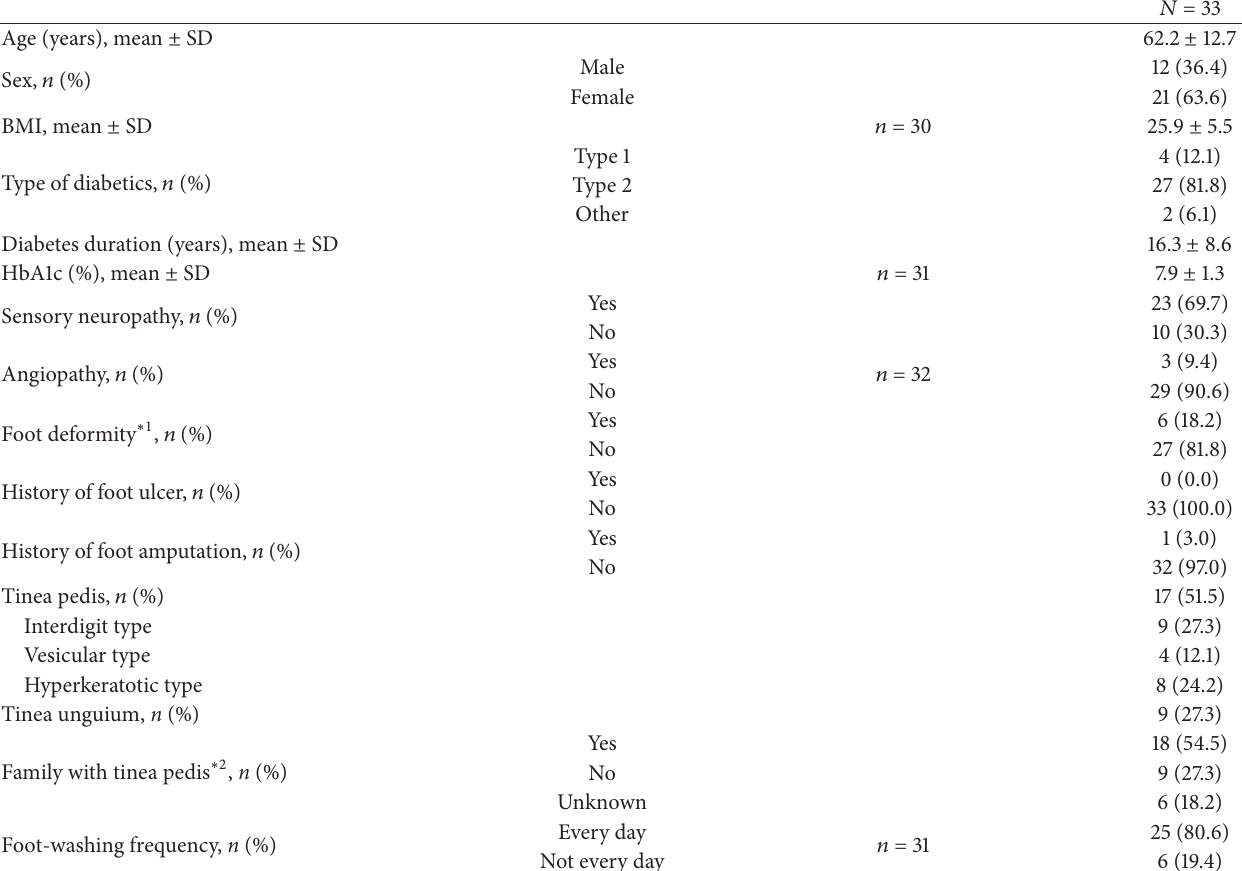
Table 1: Patients’